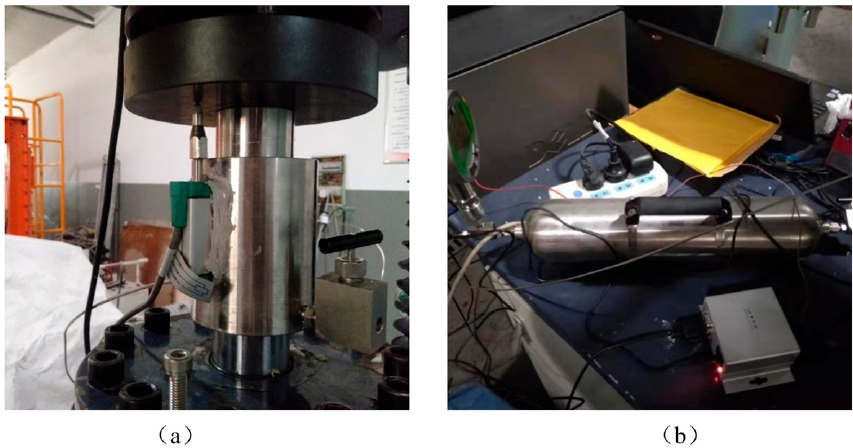
Figure 3. CT Test System. ( a ) CT scanner; ( b ) Data acquisition and processing system.